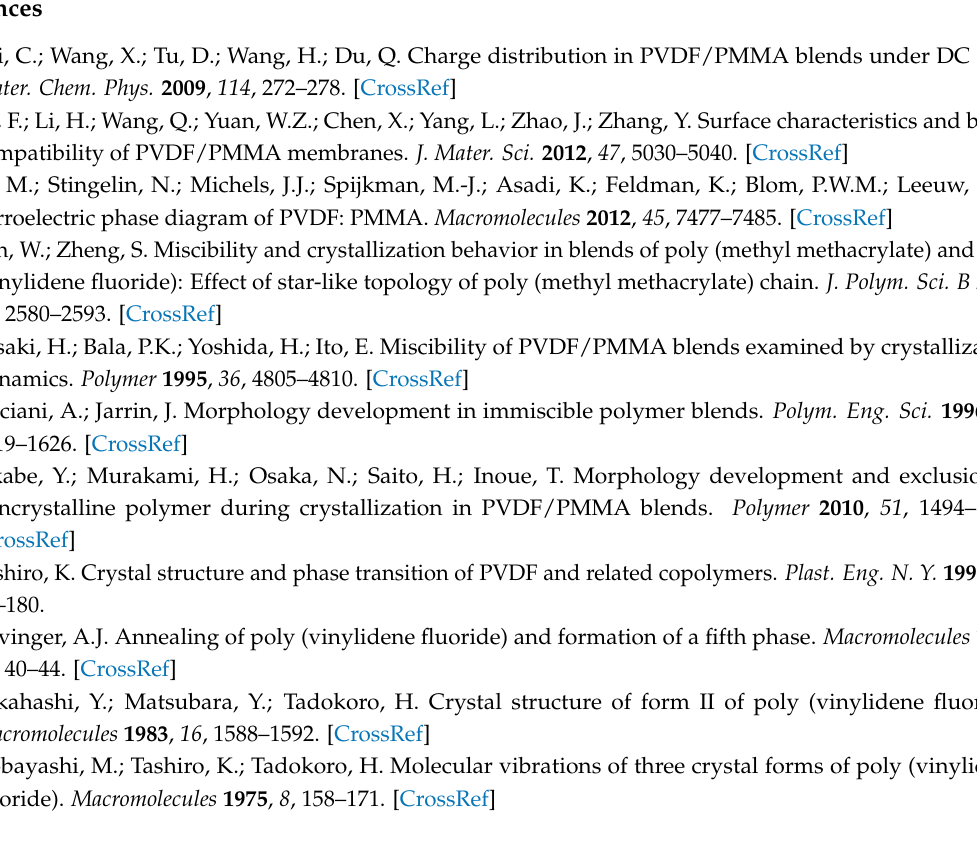
Figure S1: (A) SEM image; and (B) size distribution of PMMA latex particles. Figure S2: DSC first heating curves of: (A) PVDF@PMMA; and (B) PVDF/PMMA at various weight ratios of PVDF to PMMA. The cooling rate was − 10 ◦ C/min. Figure S3: Deconvolution of the X-ray diffraction curves for: (A) neat PVDF; (I) neat PMMA; and three series of samples: (B–E) PVDF@PMMA; (F–H) PVDF/PMMA; and (J–L)